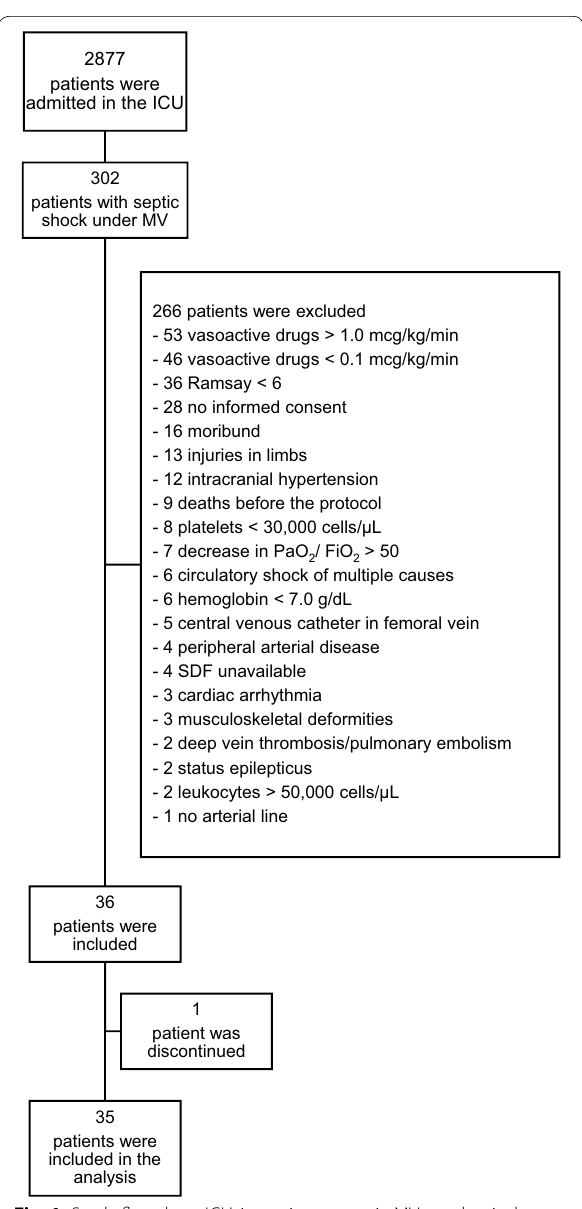
Fig. 1 Study flowchart. ICU, intensive care unit; MV, mechanical ven- tilation; PaO 2 , arterial oxygen partial pressure; FiO 2 , oxygen inspired fraction; SDF, sidestream dark